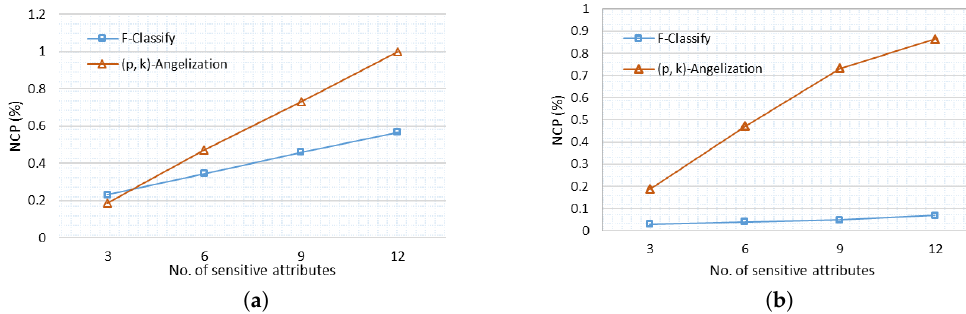
Figure 5. Normalized Certainty Penalty (NCP) ( a ) NCP Heart Disease ( b ) NCP